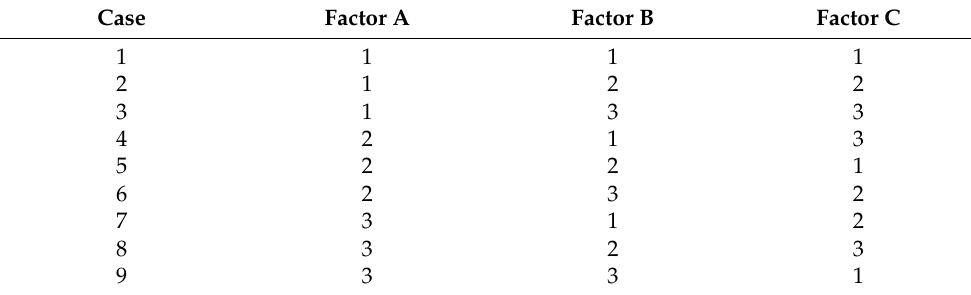
Table 5. Orthogonal test conditions.